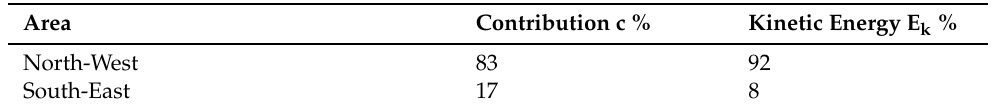
Table 3. Contribution coefficients to power-frequency characteristic and kinetic energy distribution in the two separated areas of the CE system. Area Contribution c % Kinetic Energy E k % North-West 83 92 South-East 17